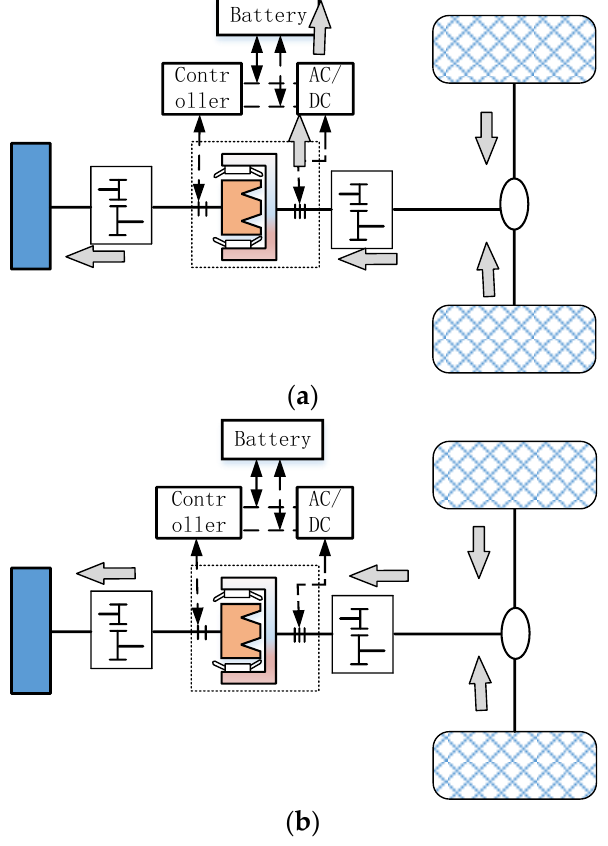
> 𝑛 = 𝑛 ; ( b ) 𝑛 . o i o i